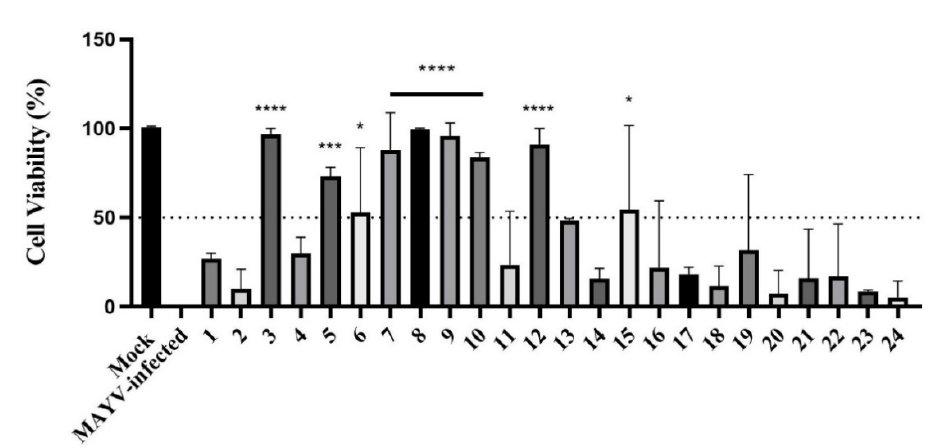
Figure 2. Antiviral screening of twenty-four cyclic ketones against MAYV. The MTT method was used to determine the cell viability of cells infected with MAYV and treated with the different compounds. For negative control, uninfected Vero cells (mock) were defined as 100% cell viability, and positive Control (MAYV-infected) was defined as 0%. **** p < 0.0001; *** p < 0.001; * p < 0.05.